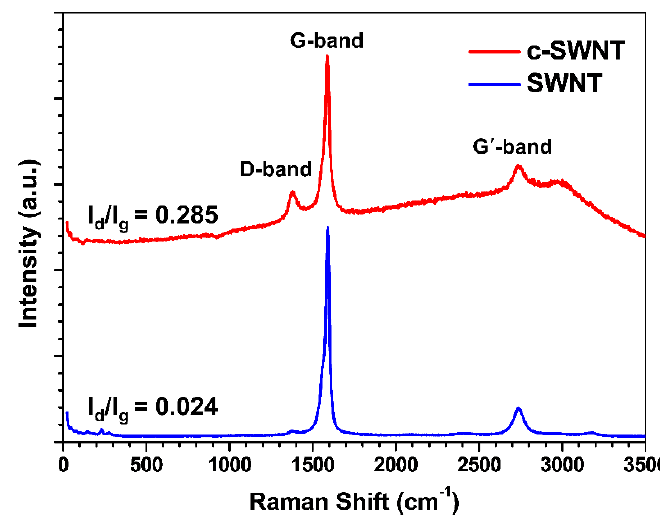
Figure 3. The Raman spectra of SWNT and c-SWNT.